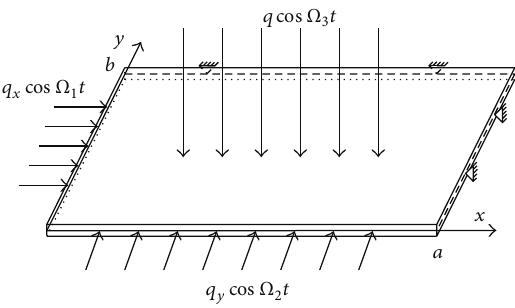
Figure 1: The model of a laminated composite piezoelectric rectan- gular plate is